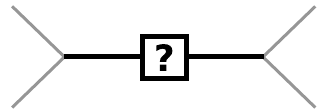
Figure 2.33: The Process Description glyph for an uncertain process